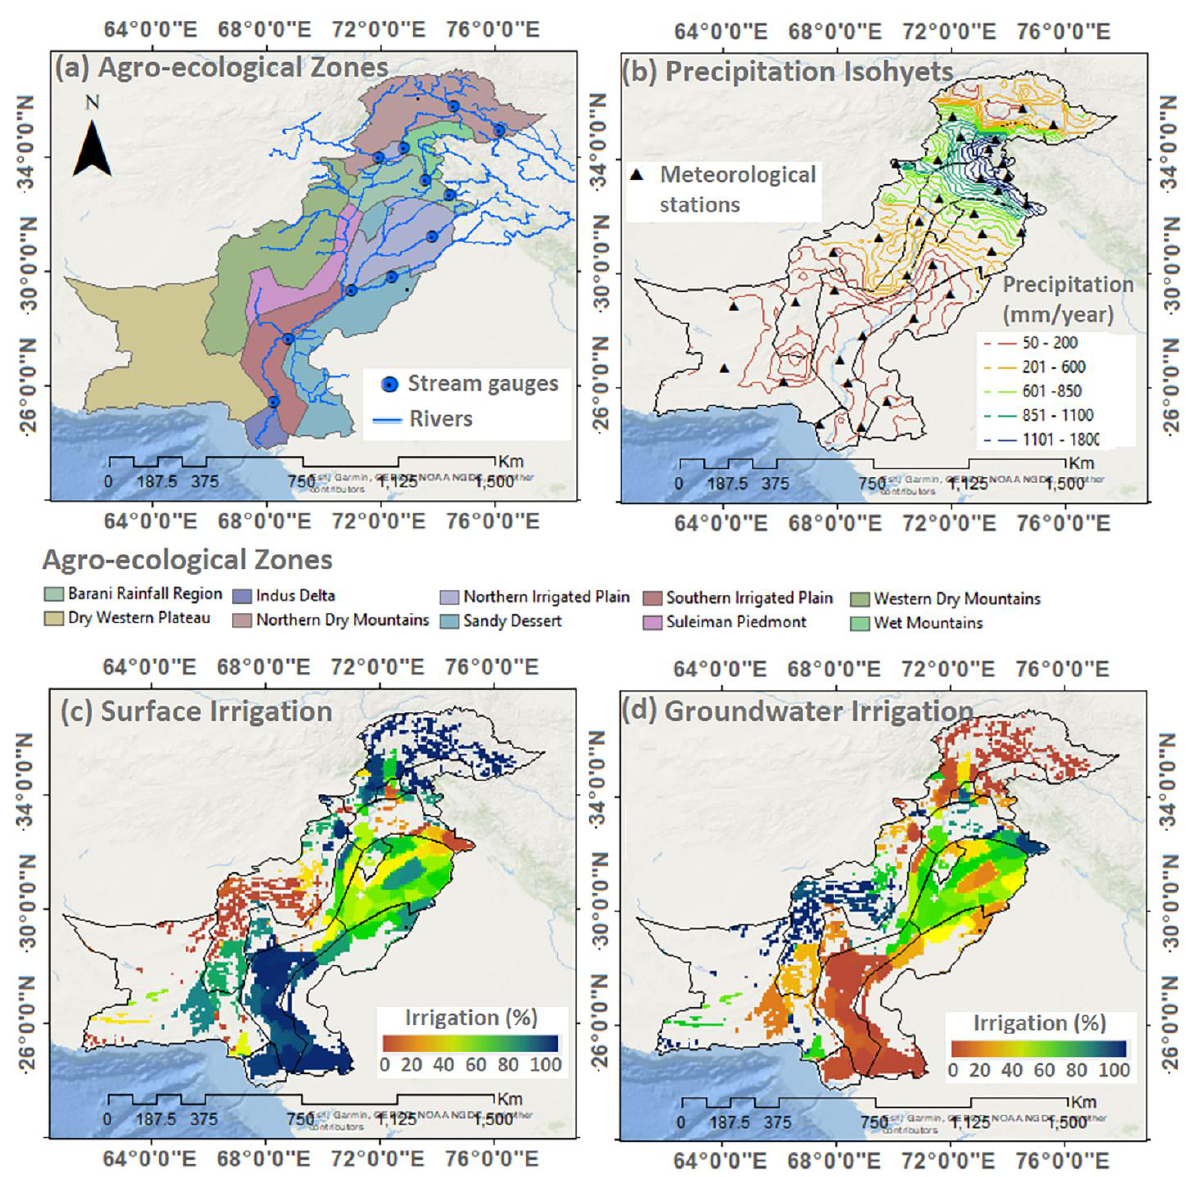
Figure 1. Map of the study area showing ( a ) geographical location of stream gauges, river networks, and 10 different AEZs, ( b ) meteorological stations and precipitation isohyets, ( c ) % irrigation with surface water, and ( d ) % irrigation with groundwater.